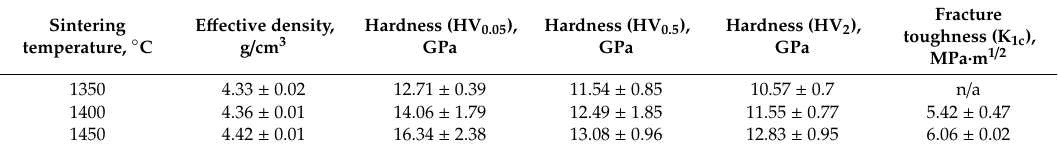
Table 3. Effective density, hardness and fracture toughness of composites SPSed at 1350, 1400 and 1450 °C.